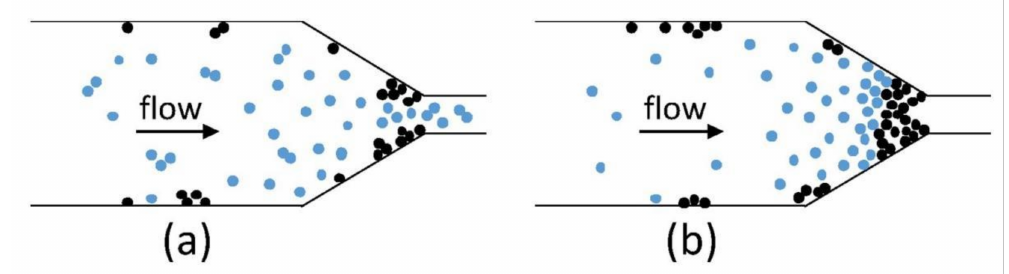
Figure 9. A schematic illustration of nozzle clogging in the PAR method, ( a ) reduced flow due to curvature, ( b ) agglomeration of powder; the blue and black dots in the figure correspond to the polymer matrix and the metal particles, respectively. Reprinted with permission from [75]. Copyright 2018,